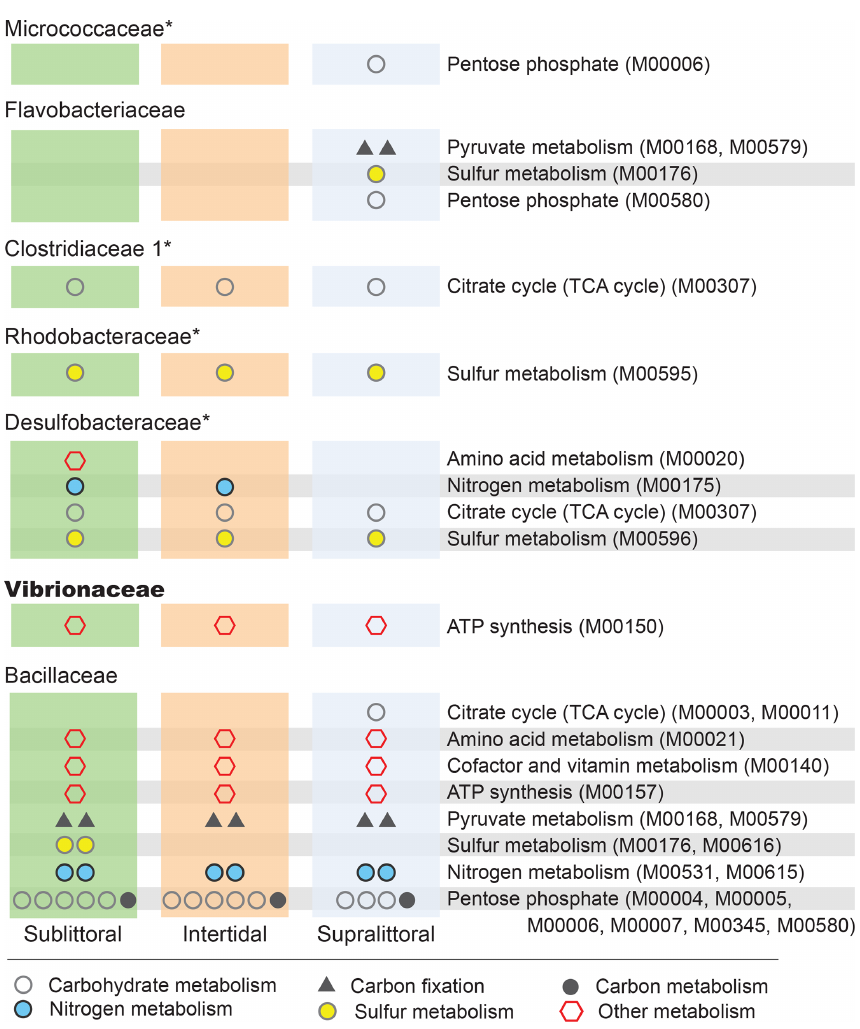
Figure 5. Zone-specific enrichment of pathway modules. Here, we show the impact that the differential abundances of major families (Fig. 4) have on potential functional profiles in each zone at the level of pathway modules. To be included here each module must be completely enriched within a single taxon in a single zone, such that the taxa account for at least 10% of the total potential functional abundance for each KO involved in the pathway. Families with a median NSTI within 1SD of 0.15 are labeled with